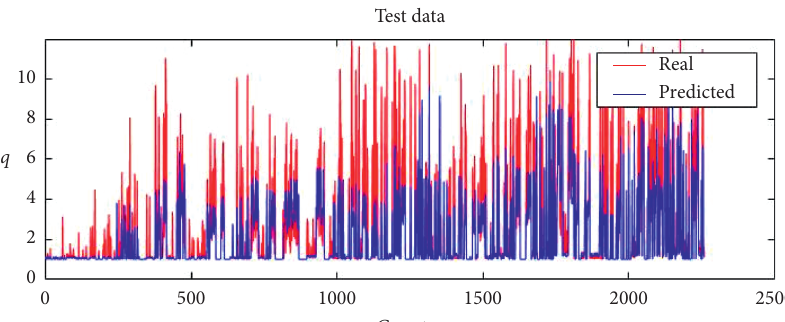
Figure 9: Real and predicted q from predicted correlation (based on the constants p 1 through p 7 which are listed in Table 3) (test data).